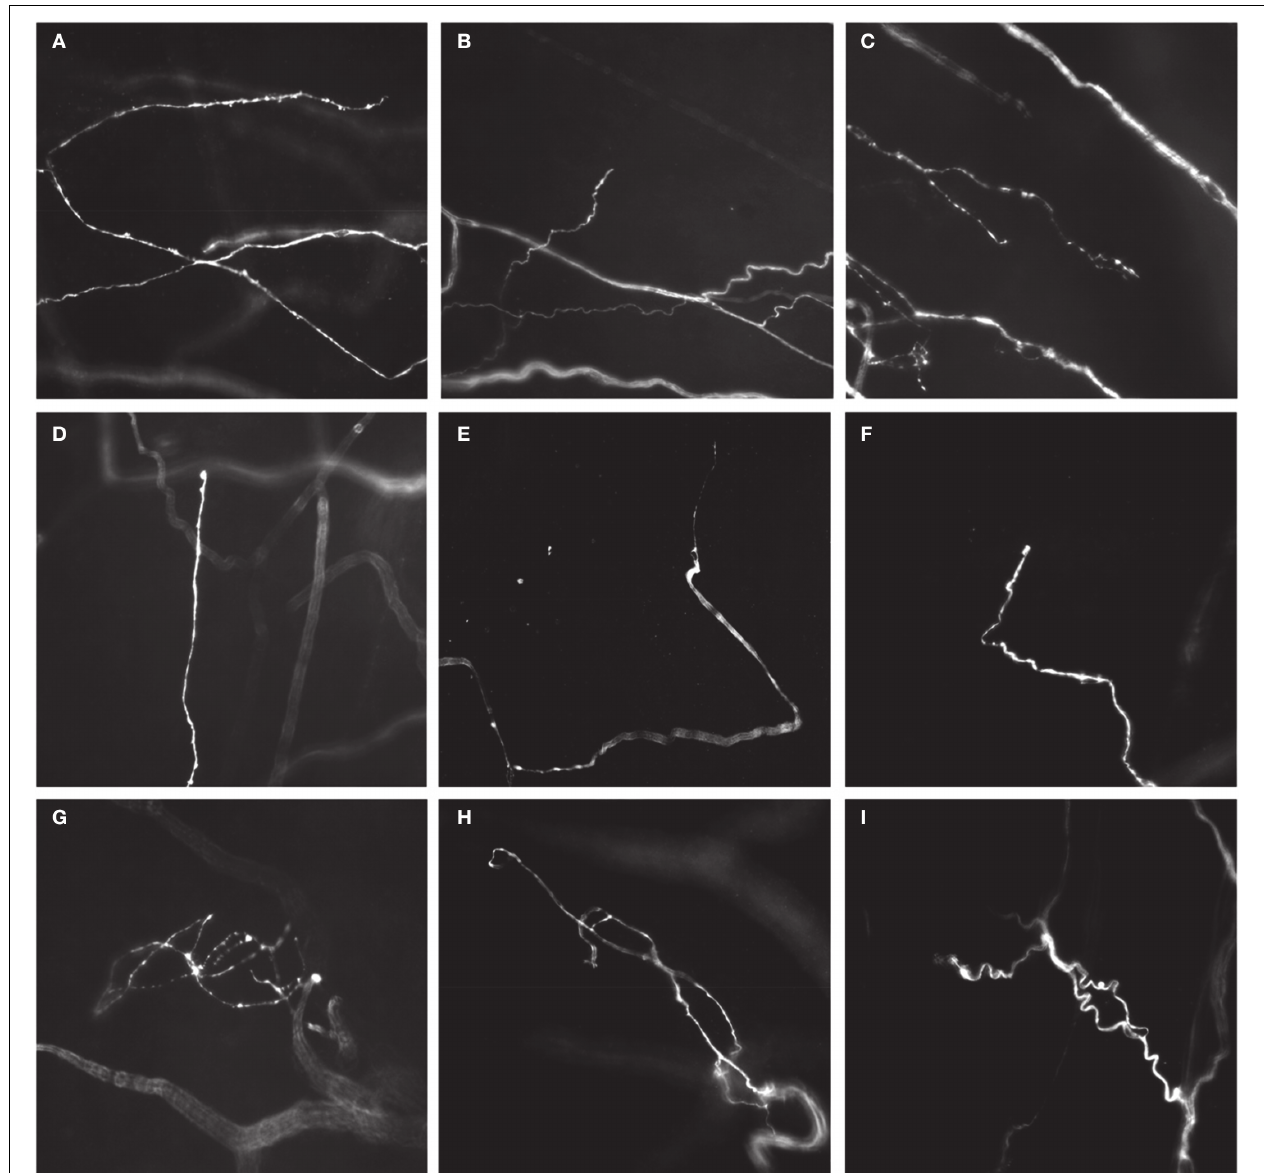
FIGURE 5 | Different types of CGRP-immunoreactive nerve endings in whole mount preparations of mouse uterine horn. Single-type nerve endings aligned in the circumferential axis of the uterine horn, adjacent to, or within circular smooth muscle (A–C) , most commonly with long single axonal branches that emanate from their parent axon (A) , or short branches from their parent axon (B) . Branching-type endings were identified that consisted of multiple short branching axon terminals, with few prominent varicosities (C)